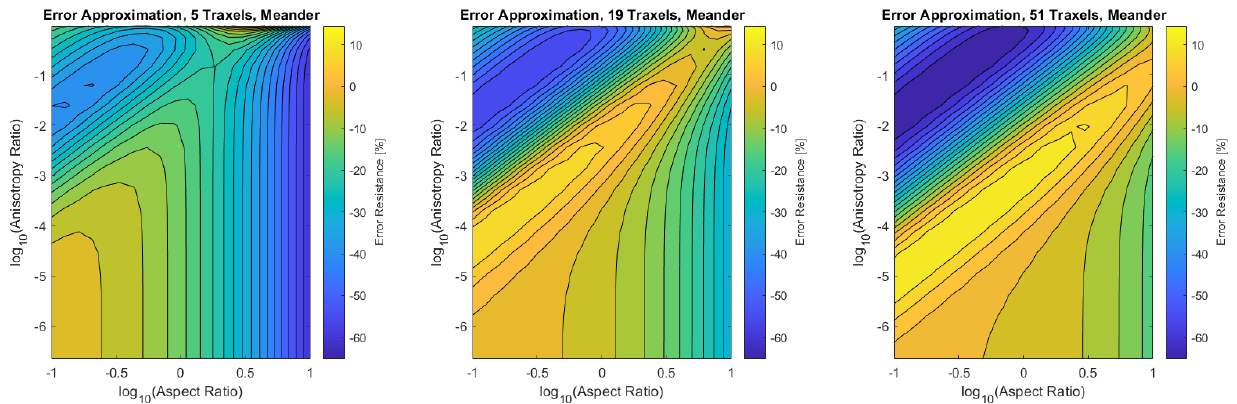
Figure A2. The error of the approximated open-ended resistance compared to the FEM simulations. The RMS-error for the different numbers of traxels is respectively 15.52%, 25.29% and 31.71%.